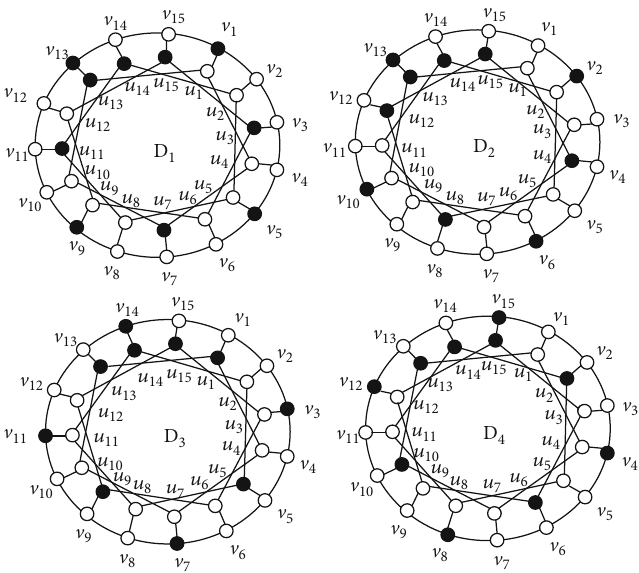
Figure 16: Eternally protecting P ð 15, 3 Þ with 10